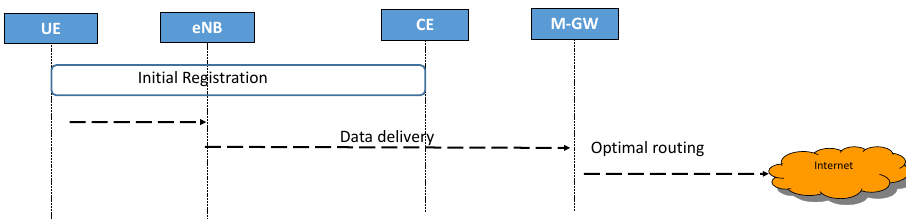
Figure 4. The data delivery procedure from Mobile host to the Internet in the proposed 5G concept.